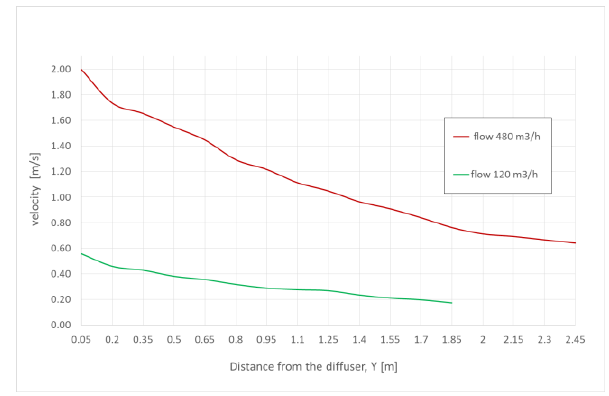
Fig. 9 . Distribution of velocity along the NSAL diffuser axis for